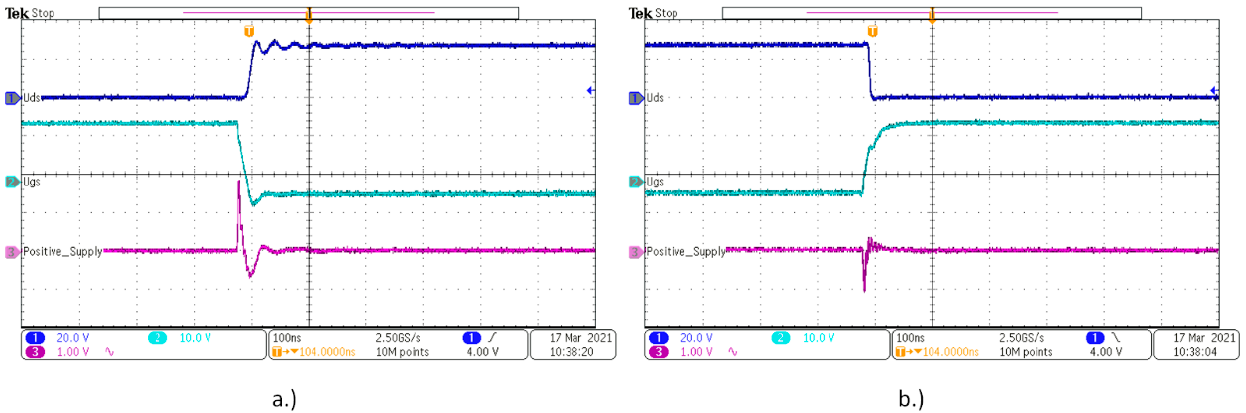
Figure 16. Power supply transients: ( a ) turn-off; ( b ) turn-on (Blue, UDS voltage 5 V/div; Cyan, UGS voltage 10 V/div; Purple, Isolated power supply positive rail 1 V/div; AC coupled).